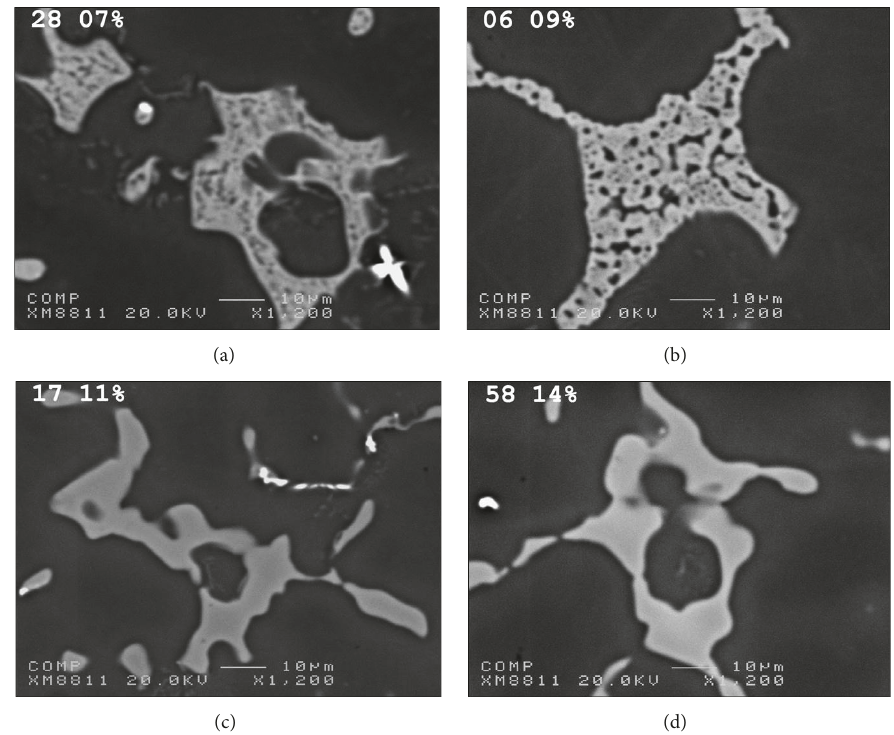
Figure 3: High magnification backscattered electron images of (a) 7% Al, (b) 9% Al, (c) 11% Al, and (d) 14% Al.